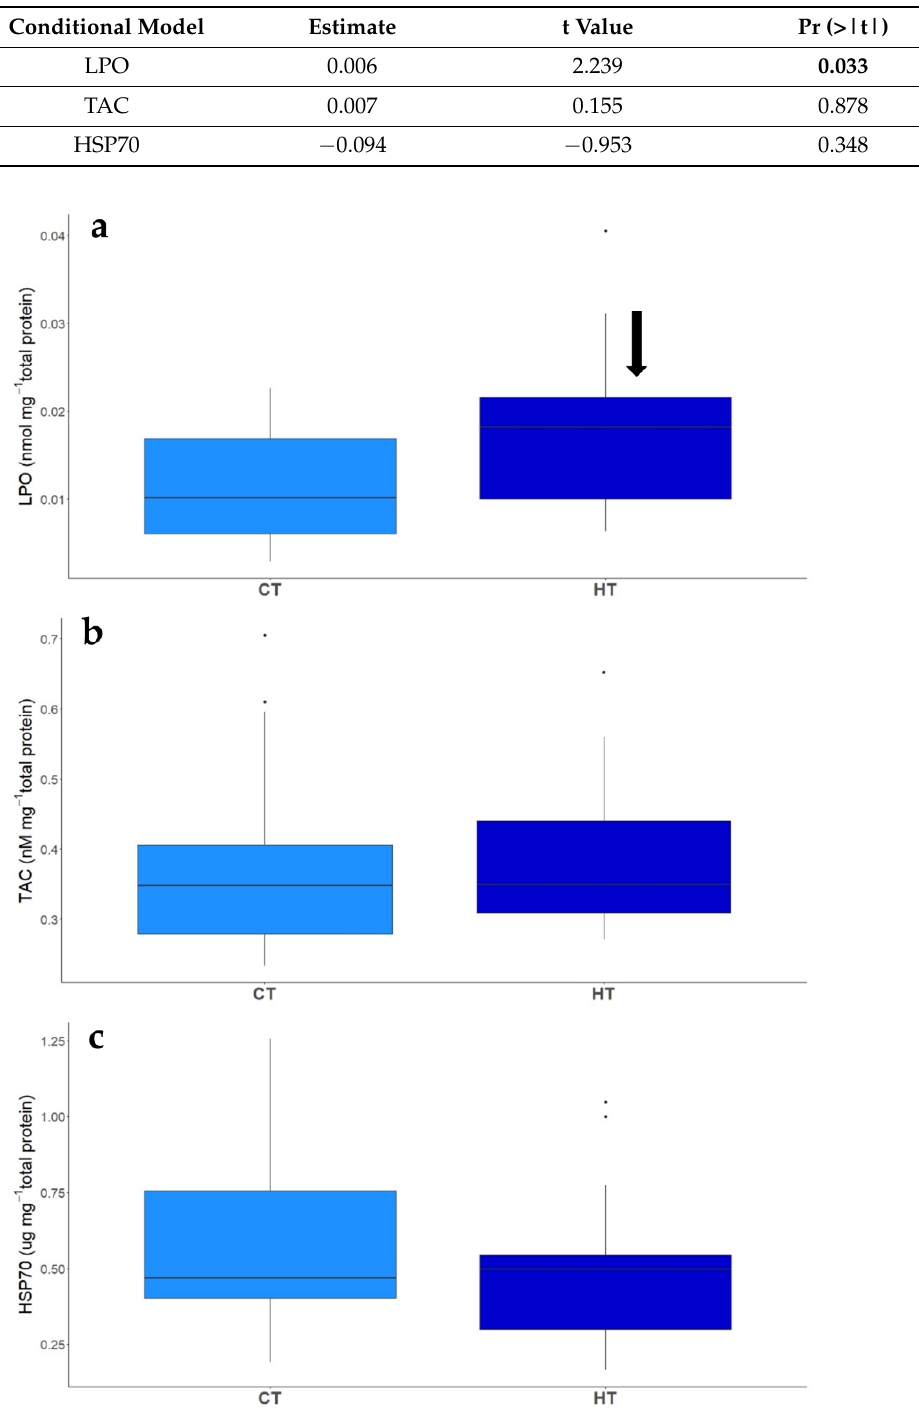
Figure 6. Effect of exposure to Control (CT) and High (HT) temperature treatments on LPO ( a ), TAC ( b ) and HSP70 ( c ) of larvae of two-spotted goby, Pomatochitus flavescens, at hatching. Black arrows indicate significant treatment effects ( p ≤ 0.05) as compared to CT + HR treatment.